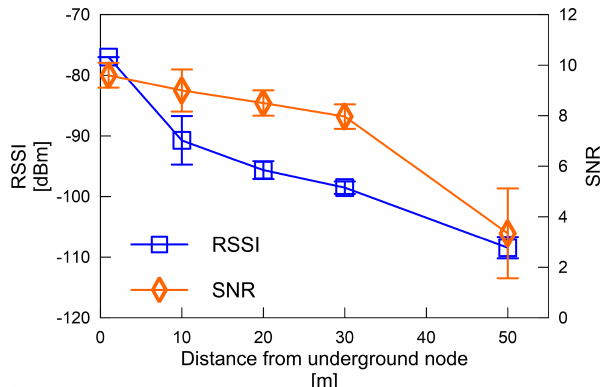
Figure 5. RSSI and signal-to-noise ratio (SNR) as a function of the linear distance between the underground node and the above- ground hub. The above-ground hub was positioned at five distances from the underground node (1, 10, 20, 30, and 50m). At each dis- tance, the hub recorded one reading per minute for 10min at a con- stant height of 2m above ground with the same antenna orientation. Transmission of the underground node was set to 20dBm. Error bars indicate the standard deviation from the average of 10 mea- surements at each